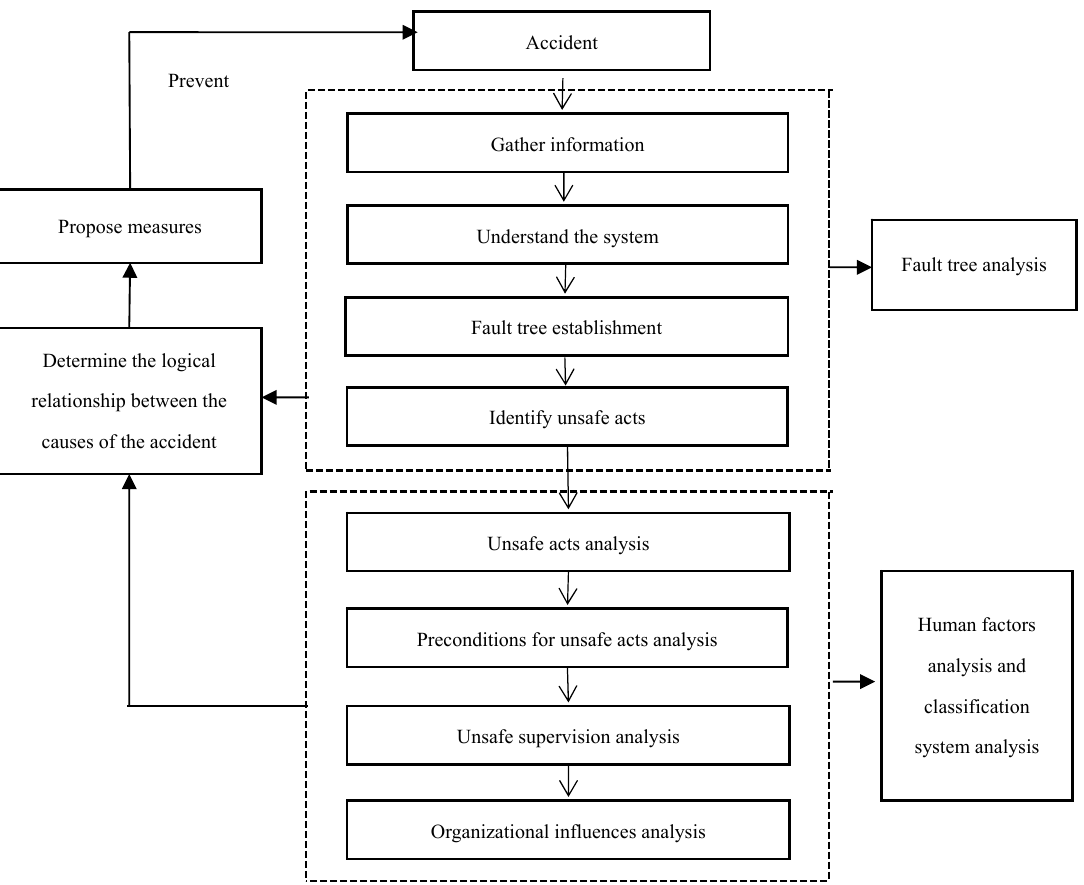
Figure 1. Combination of fault tree analysis (FTA) and the Human Factors Analysis and Classification System (HFACS).